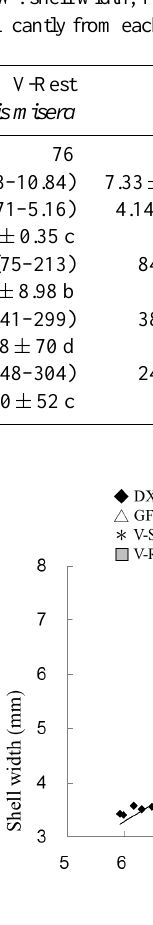
Figure 5. Relationship between shell length and shell width of Anachis and Euplica snails from different sites. Different letters fol- lowing the values in the legend indicate that the regression lines differ significantly ( p< 0 .